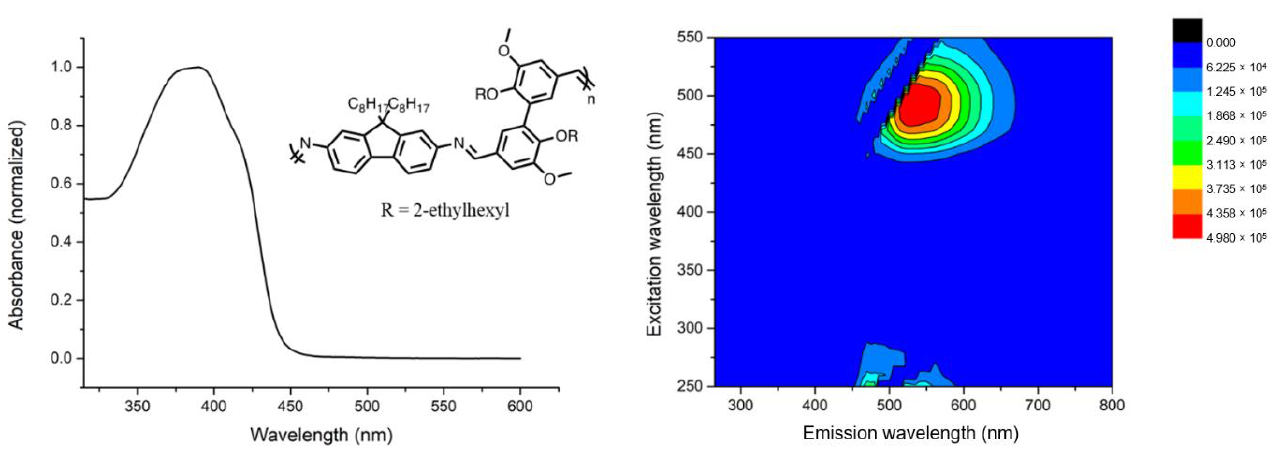
Figure 3. Absorbance spectrum and emission-excitation spectra of P1 in film (drop-casted on quartz).